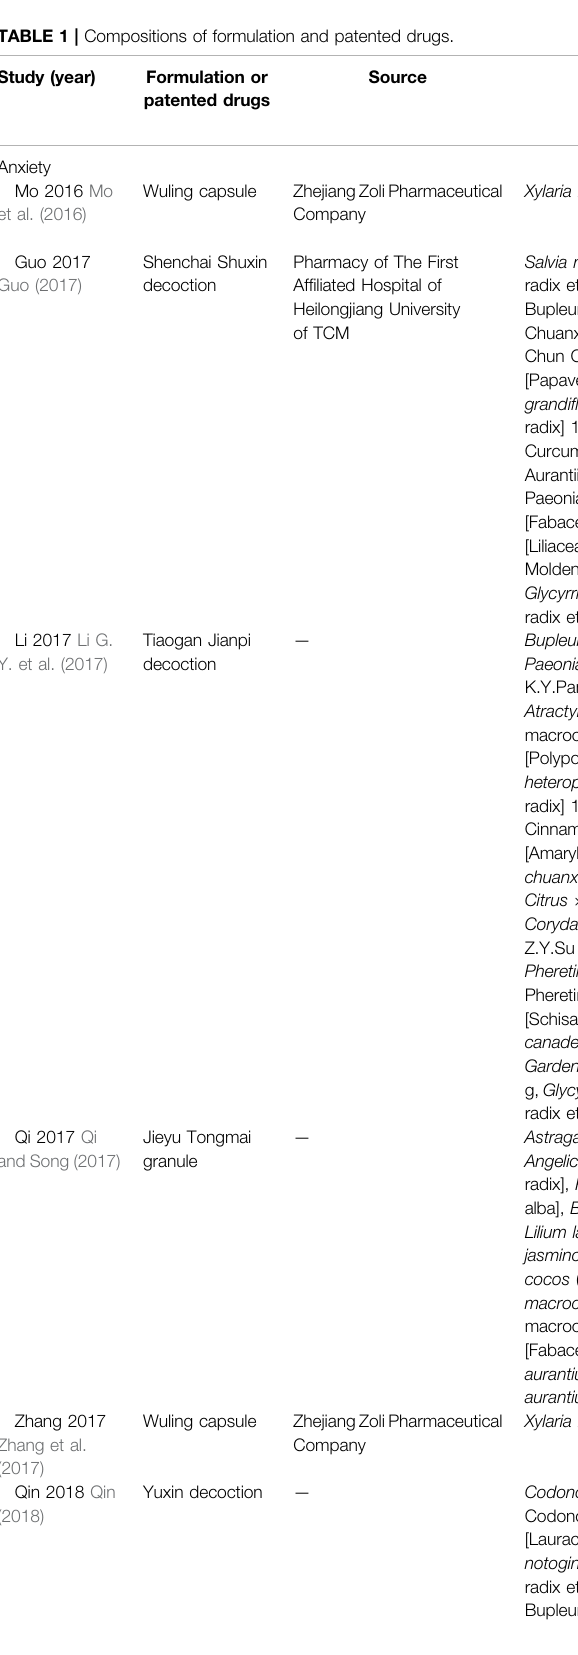
TABLE 1 | Compositions of formulation and patented